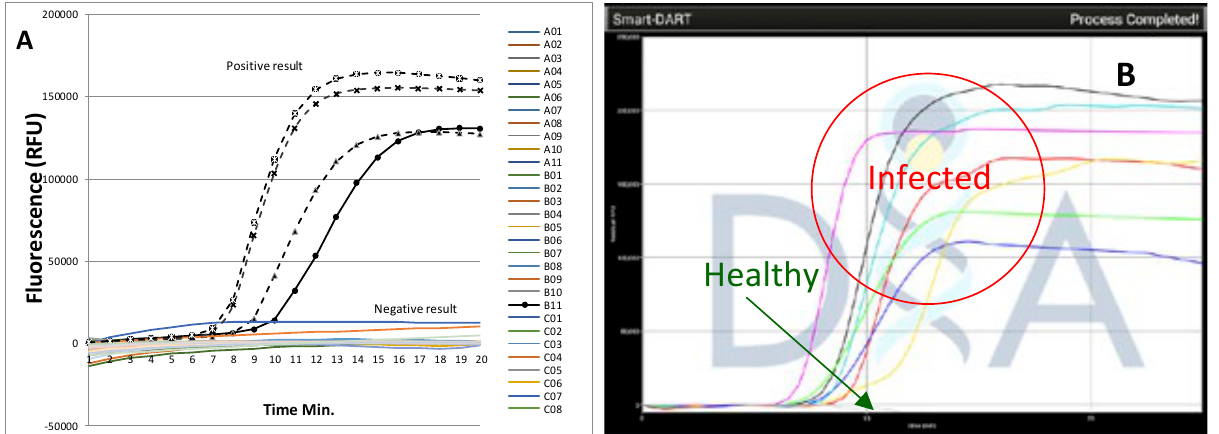
Figure 3. Xf- infected olive samples showing positive results in real-time LAMP with 20 min reaction time in both real-time IQ5 Bio-Rad device (A), and in Smart-Dart device equipped with D&A software (B). Xf -negative samples showed linear